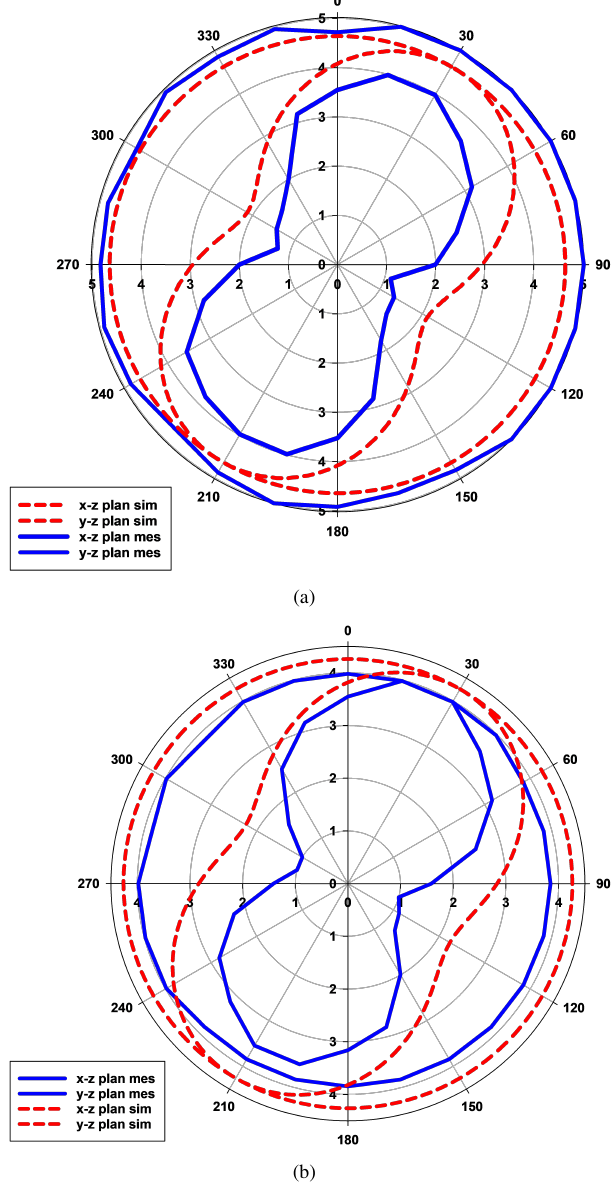
FIGURE 12: Measured read range patterns in x-y and y-z planes: (a) for Ant1(868 MHz), (b) for Ant2(915